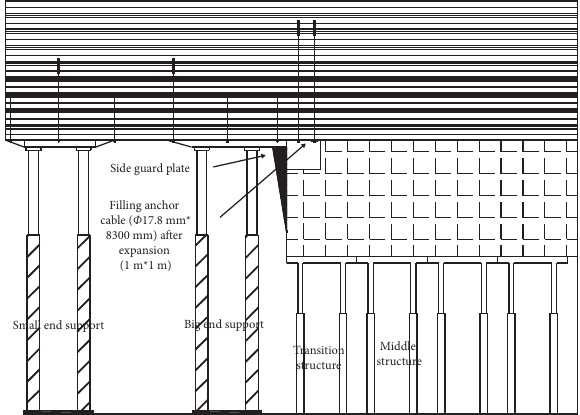
Figure 6: Cutting the repair